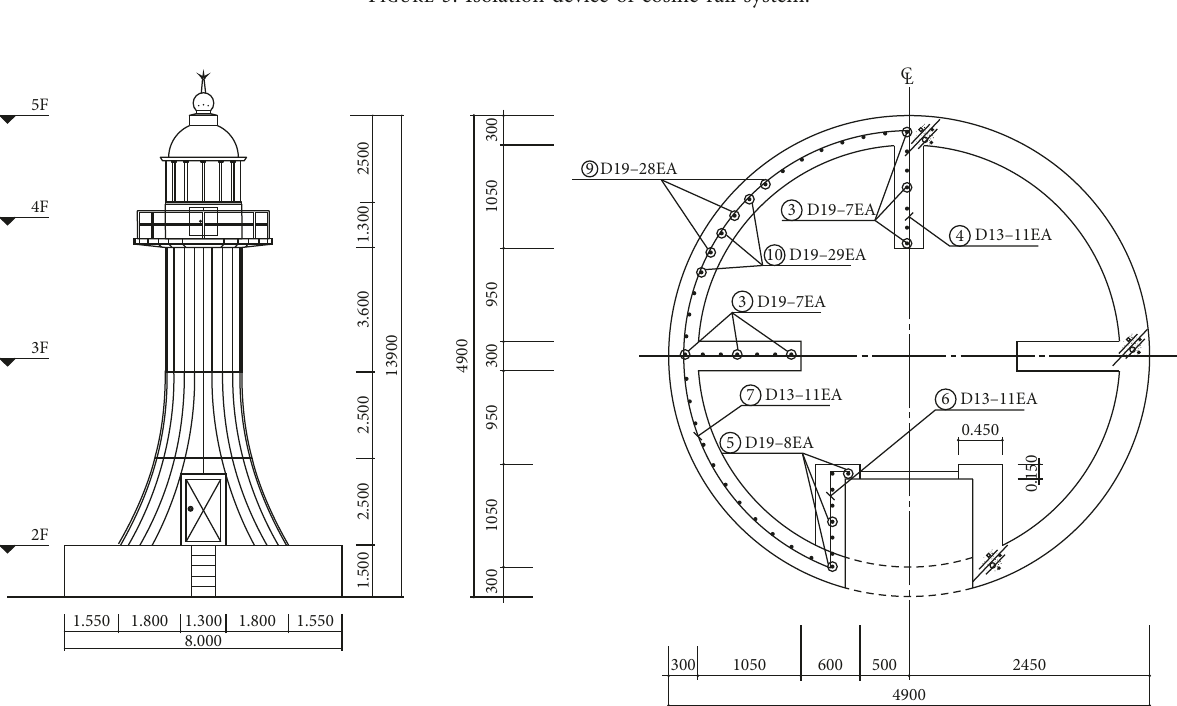
Figure 4: Section and elevation of the lighthouse.